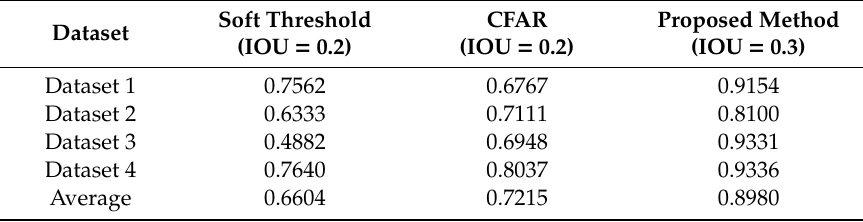
Table 2. Precision performance for deep learning flexible boundary regression (DLFBR) compared to the soft threshold and constant fault alarm rate (CFAR)